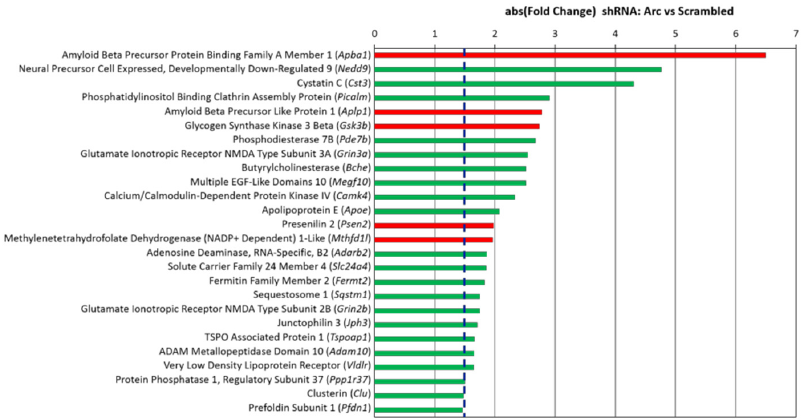
Figure 13. Alzheimer’s susceptibility genes affected by Arc knockdown. The expression levels of 26 AD susceptibility genes were affected when activity-dependent Arc expression was prevented by an shRNA. Green bars indicated that the mRNA level was downregulated, while red bars indicate upregulation. The blue line indicates an absolute fold change of 1.5.